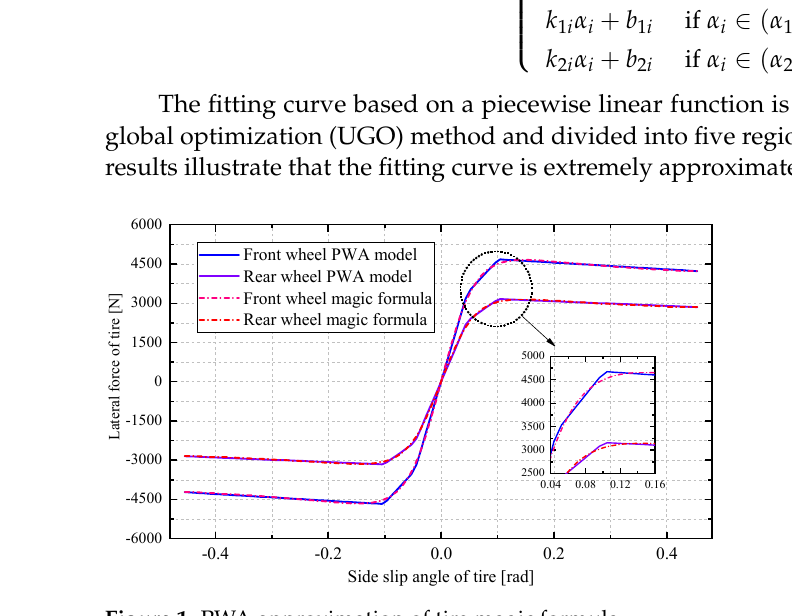
Figure 1. PWA approximation of tire magic formula.